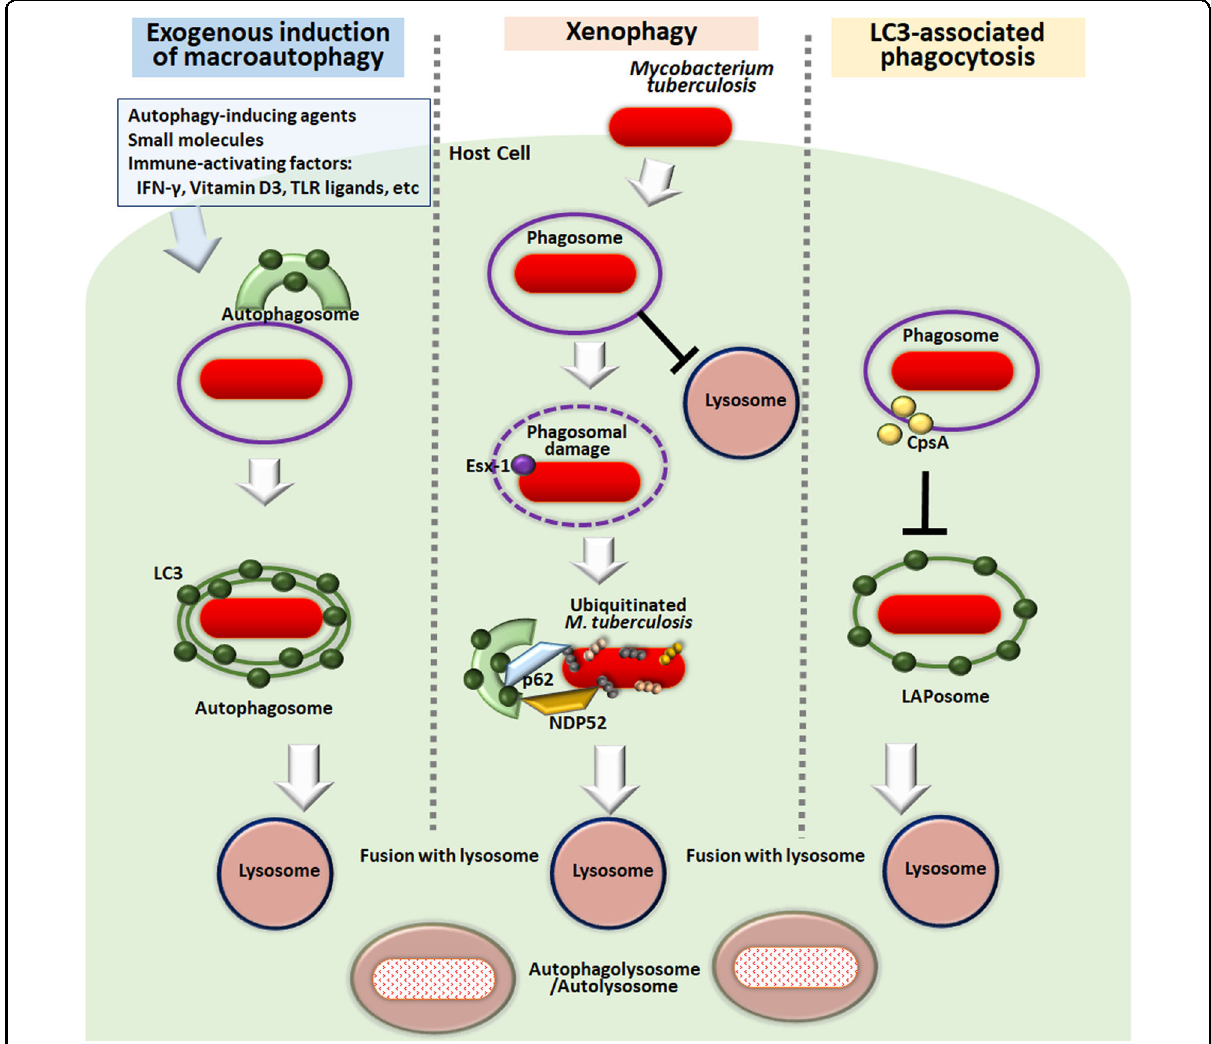
Fig. 1 Autophagy pathway activation during Mtb infection. After phagocytosis, Mtb can reside in phagosomes to escape phagosomal acidi fi cation. Numerous immunological and pharmacological autophagy activators (box on the left ) can enhance the restriction of intracellular Mtb growth by overcoming Mtb escape from phagosomal maturation. Mtb phagosome damage through the ESX-1 system is able to trigger ubiquitination of Mtb and its DNA to recruit autophagic adaptors, thereby linking this system to the autophagic machinery. Although much less is known about LAP during Mtb infection, Mtb CpsA has been reported as an inhibitory component in resistance to LAP during infection. IFN interferon, LC3 Microtubule-associated proteins 1A/1B light chain 3B, NDP52 Nuclear domain 10 protein 52, TLR Toll-like